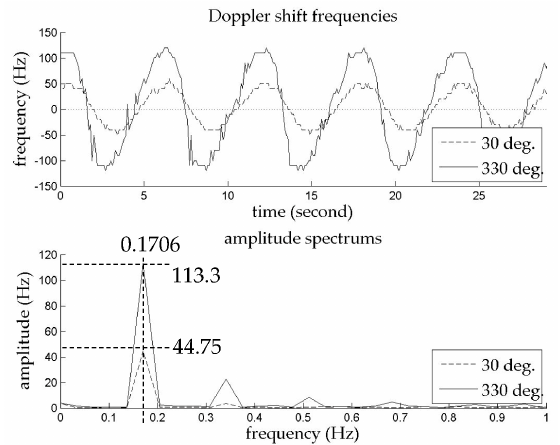
Figure 16. Two extracted Doppler shift frequencies and amplitude spectrums. The harmonics of wave frequency exist.